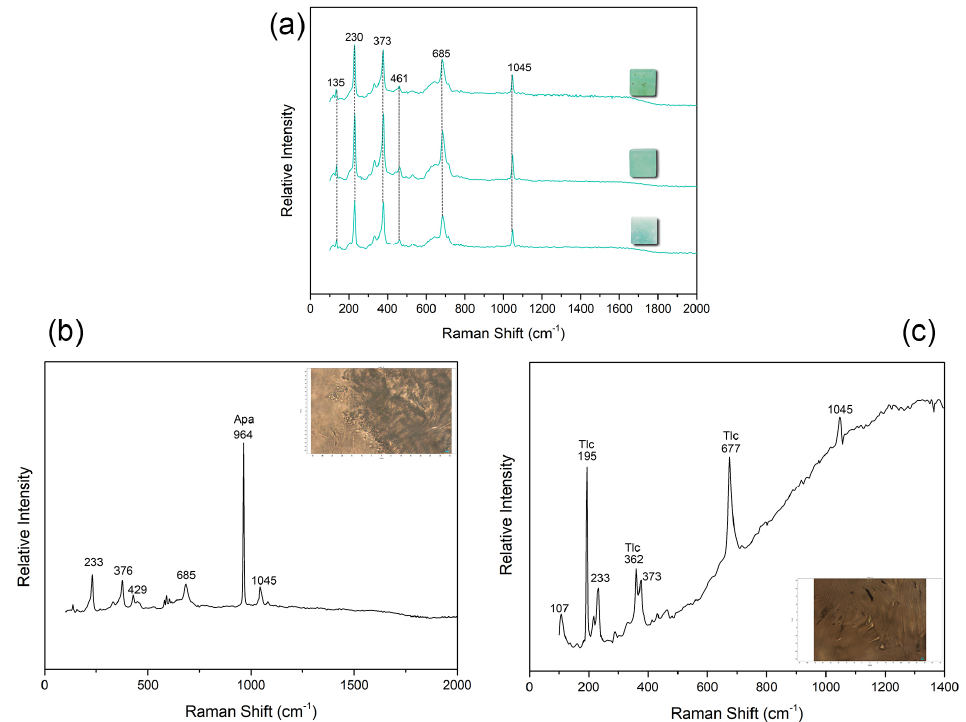
Figure 5. ( a ) Raman spectra of the bluish-green serpentinite samples. ( b ) Raman peaks of apatite at 964 cm −1 . ( c ) Raman peaks of talc at 195 cm −1 , 362 cm −1 , and 677 cm −1 .